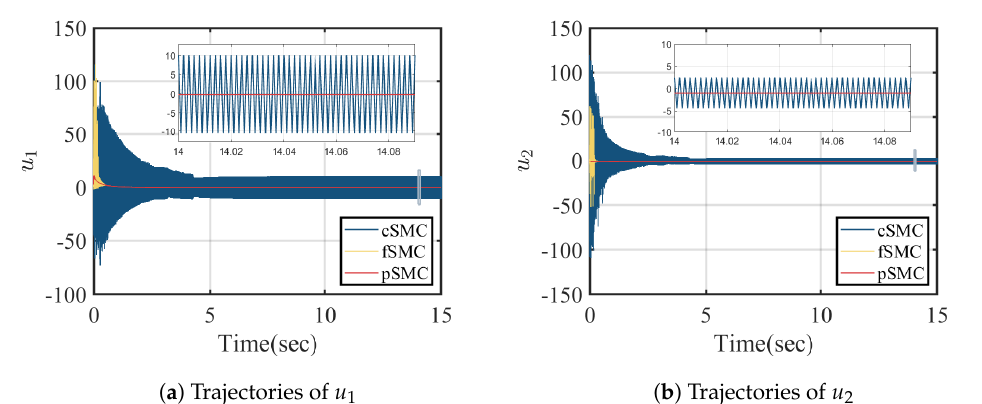
Figure 6. The trajectories of control variables u 1 and u 2 with continuous approximation when ρ b = 0.9: cSMC (Blue solid line), fSMC (Yellow solid line) and pSMC (Red solid